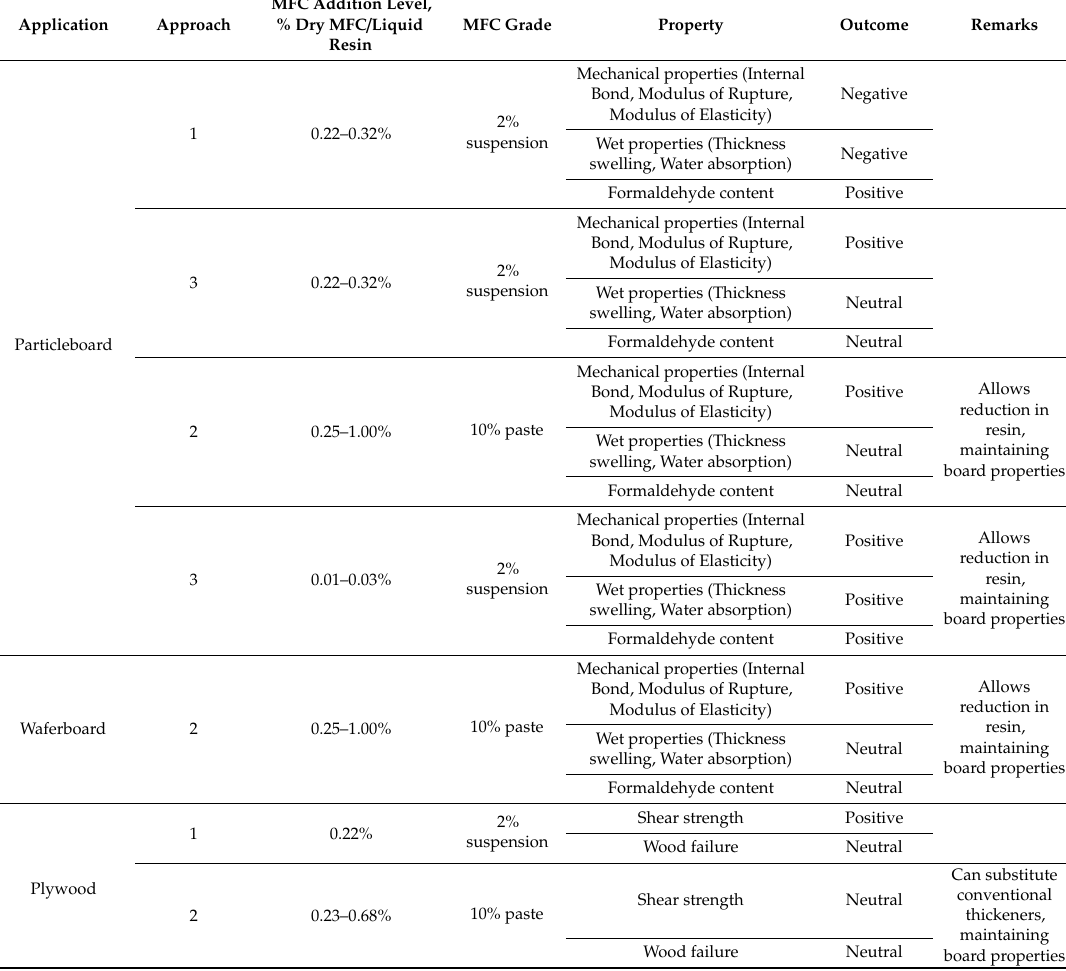
Table 17. Conclusions and general